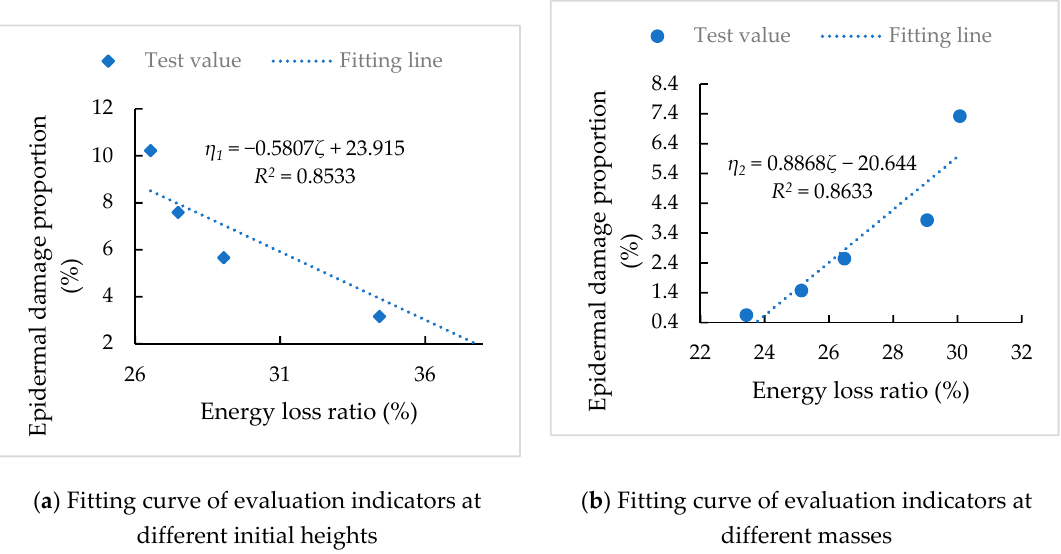
Figure 9. Linear analysis of epidermal damage proportion and energy loss ratio.